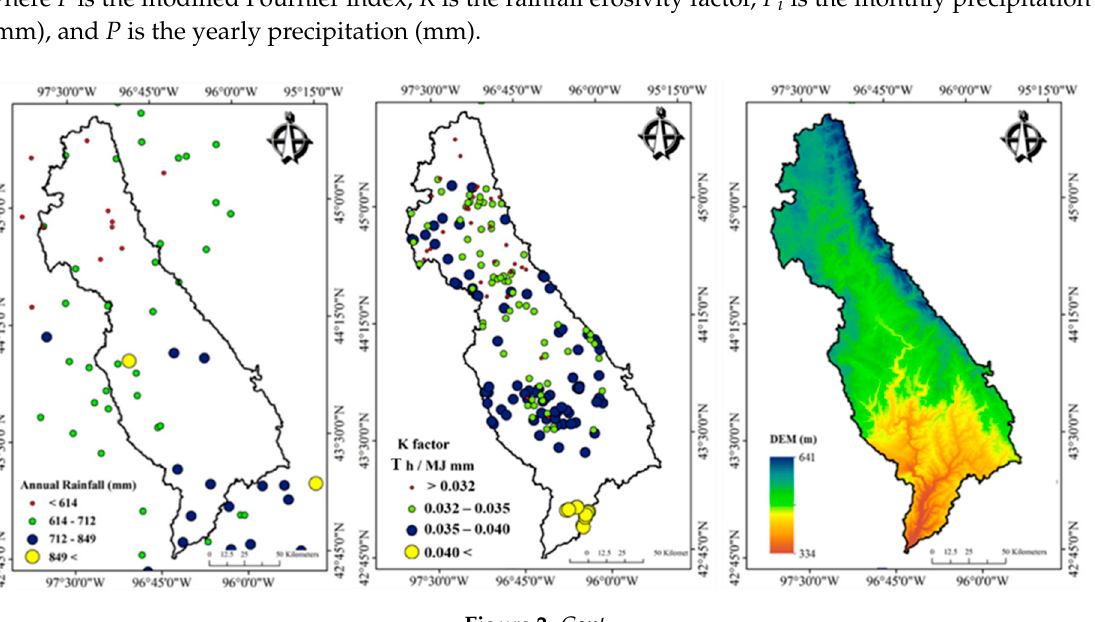
Figure 2. The spatial distribution of rain gauge stations, soil samples, DEM and land use maps for 2008, 2010 and 2015 in the watershed located in Northern Great Plains of USA. 2.2.2. Soil Erodibility (K) The value of K depends on the soil properties and is defined by quantifying of soil loss under a standard unit plot condition [3,13,14]. K factor data for 200 soil samples (Figure 2) in the BSR watershed were downloaded from Soil Survey Geographic Data (SSURGO). The summary statistics of the related basic soil information to K factor in the study area is presented in Table 1. We then used artificial neural networks (ANN) to correlate value of K (point data) with ancillary variables (grid data) according to the scorpan framework [23] in order to generate K gridded map across the study area with spatial resolution of 30 × 30 m. The digital soil mapping (DSM) relies on the scorpan spatial prediction function [23]: 𝑆 = 𝑓(𝑠, 𝑐, 𝑜, 𝑟, 𝑝, 𝑎, 𝑛) + 𝑒 (5) where S is a soil property (e.g., Soil erodibility), f is a function (e.g., ANN) and scorpan factors are soil, climate, organisms, relief, parent materials, age and spatial position, respectively; and where e is the error. In the current study, based on the understanding of the factors which may affect soil erodibility distribution and availability of such ancillary data [31], two kinds of ancillary variables listed in Table 1 were used. These ancillary data included terrain attributes and remote sensing data. Specifically, a total of 10 terrain attributes extracted from a preprocessed SRTM DEM (Shuttle Radar Topography Mission Digital Elevation Model) using Saga GIS software [32]. A total of 10 remote sensing indices extracted from Landsat 8 Operational Land Imager (OLI) images. The digital numbers